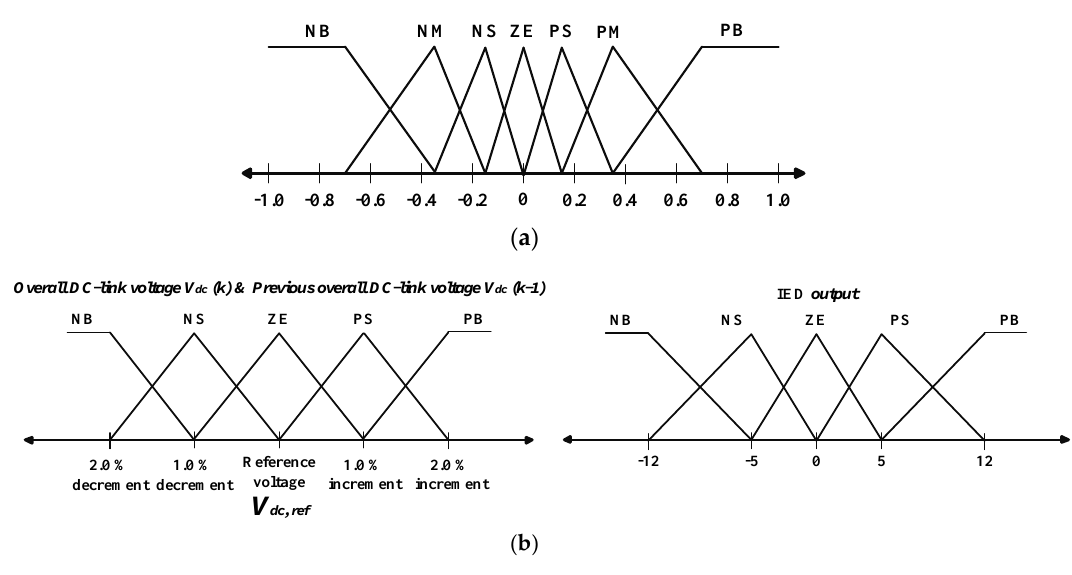
Figure 4. Fuzzy membership functions for input and output variables used in FLC: ( a ) conventional algorithm with FLC technique [24,26], and ( b ) proposed algorithm with IED control. Table 1. Fuzzy rule base for the conventional algorithm with FLC technique [20,21,26,27]. CE(k)